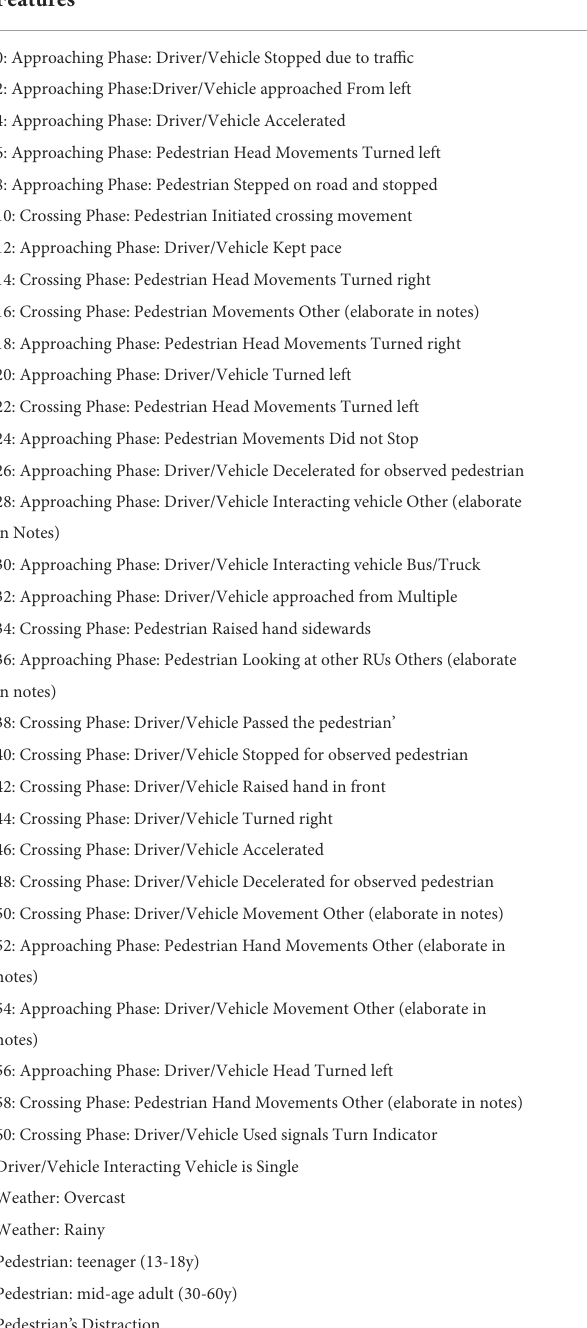
TABLE 1 List of the 74 features selected for the sequence patterns analysis, of which, 62 are temporal events and 12 are environmental descriptor events (Camara et al., 2018b,c).